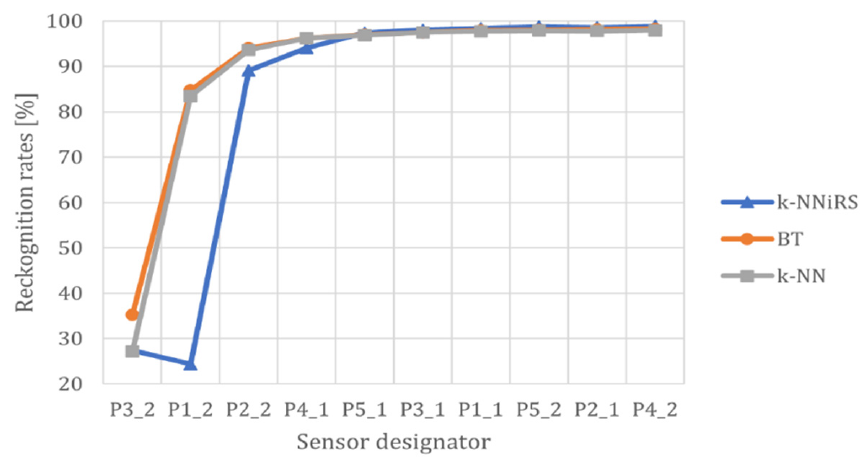
Figure 11. Graphs of gesture classification performance by algorithms with the highest average performance against the number of sensors.